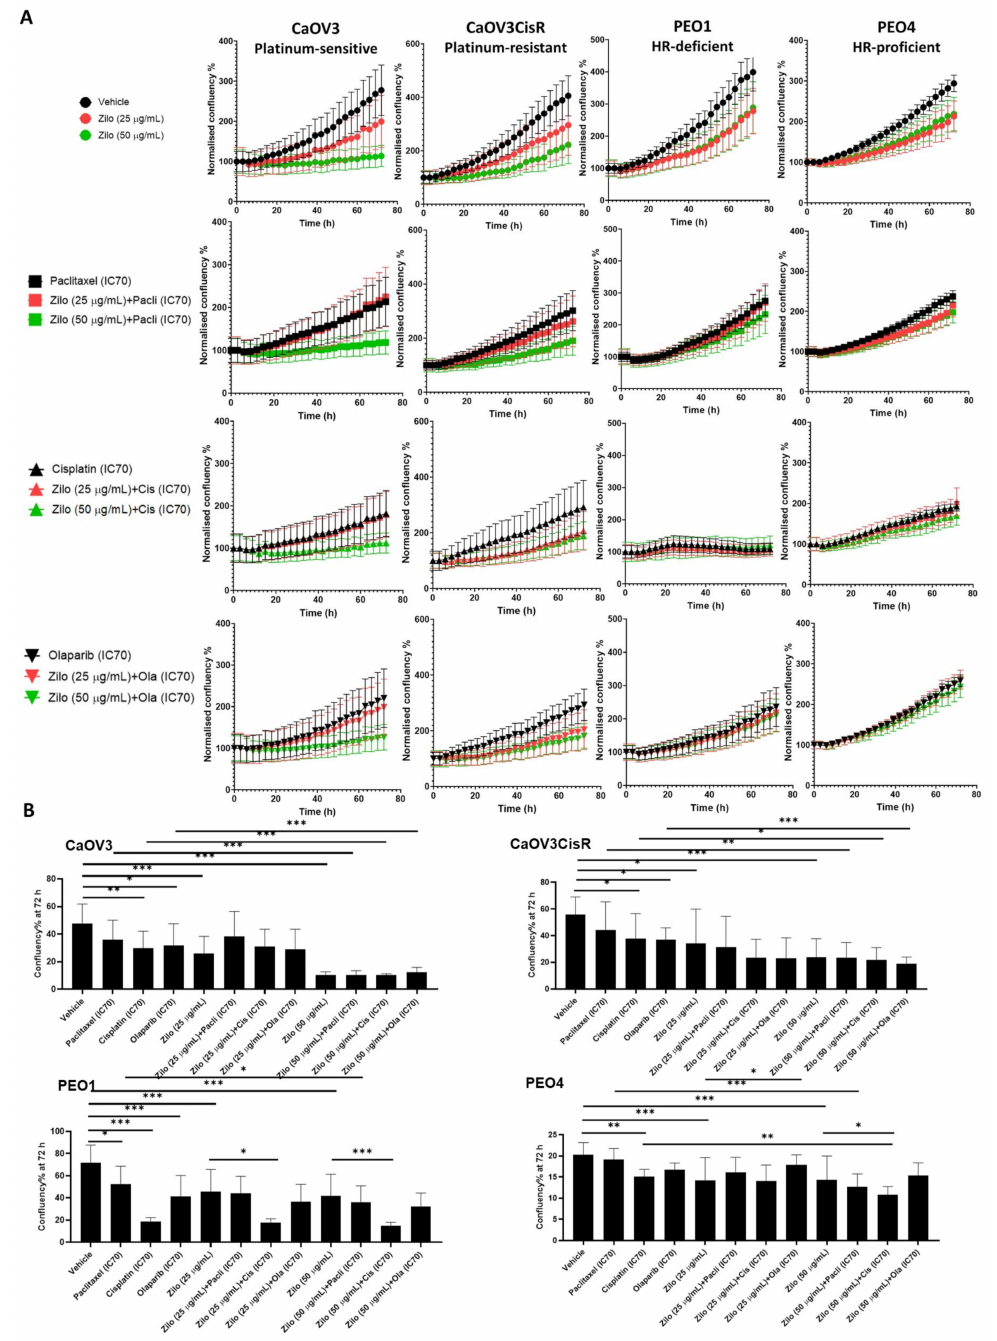
Figure 1. The effect of zilovertamab (“zilo”) +/ − Paclitaxel, Cisplatin, Olaparib at IC70 doses on high-grade serous ovarian cancer cell lines CaOV3, CaOV3CisR, PEO1 and PEO4. ( A ). Confluency of cell lines over 72 h of treatments analysed by IncuCyte S3. The confluency of each time point was normalised against the baseline. ( B ). Differences in cell confluency following each treatment compared with the control (vehicle for single treatment, single arm for combined therapies) at 72 h. Significance of the comparisons was assessed using two-way ANOVA with a Dunnett/Tukey correction for multiple comparison. * Adjusted p < 0.05 ** Adjusted p < 0.01, *** Adjusted p < 0.001. For each panel, n = 5, error bar =